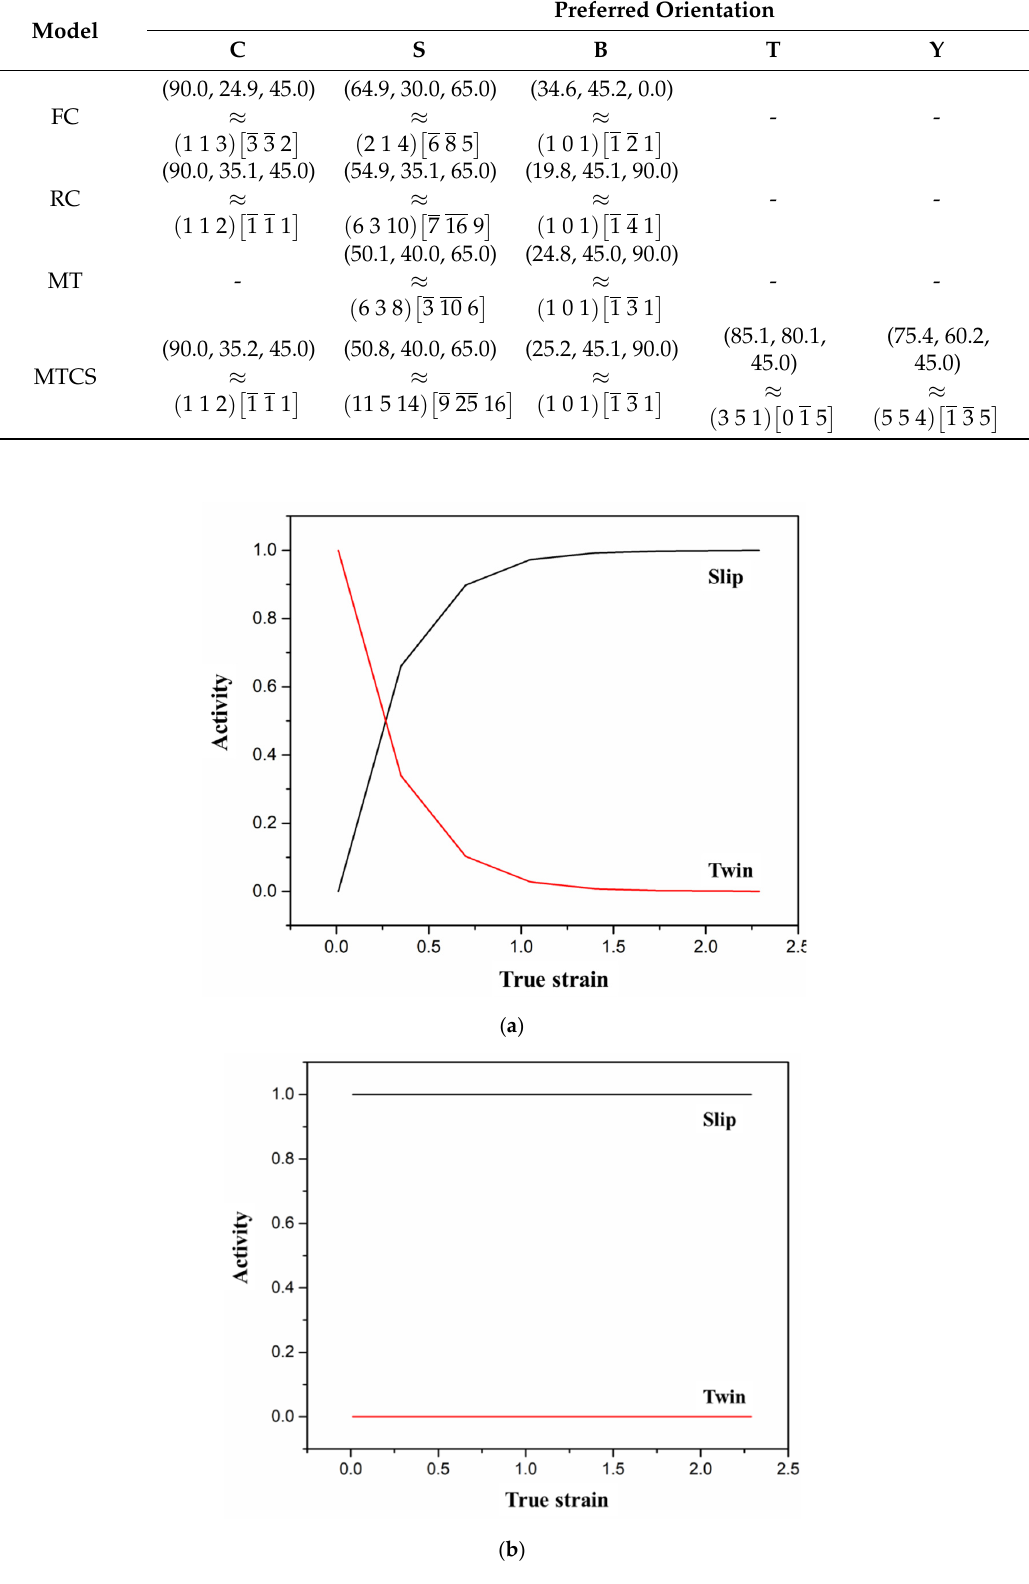
Figure 5. The activity plot of the slip and twin systems for ( a ) MT-model and ( b ) MTCS- model.